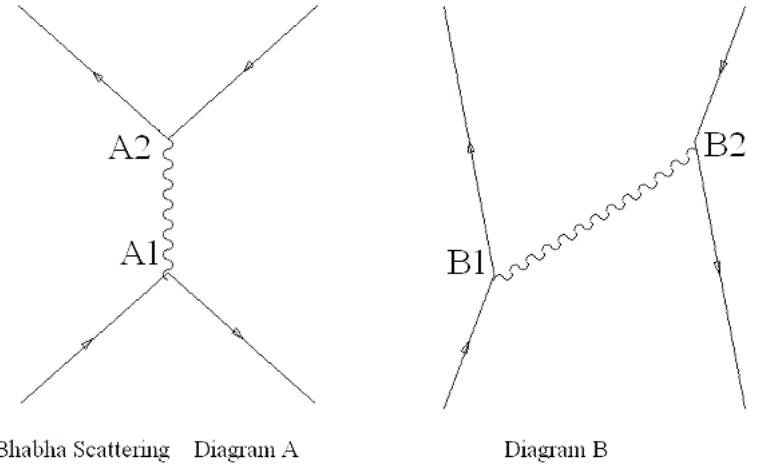
Fig. 8. Feynman diagrams for Bhabha